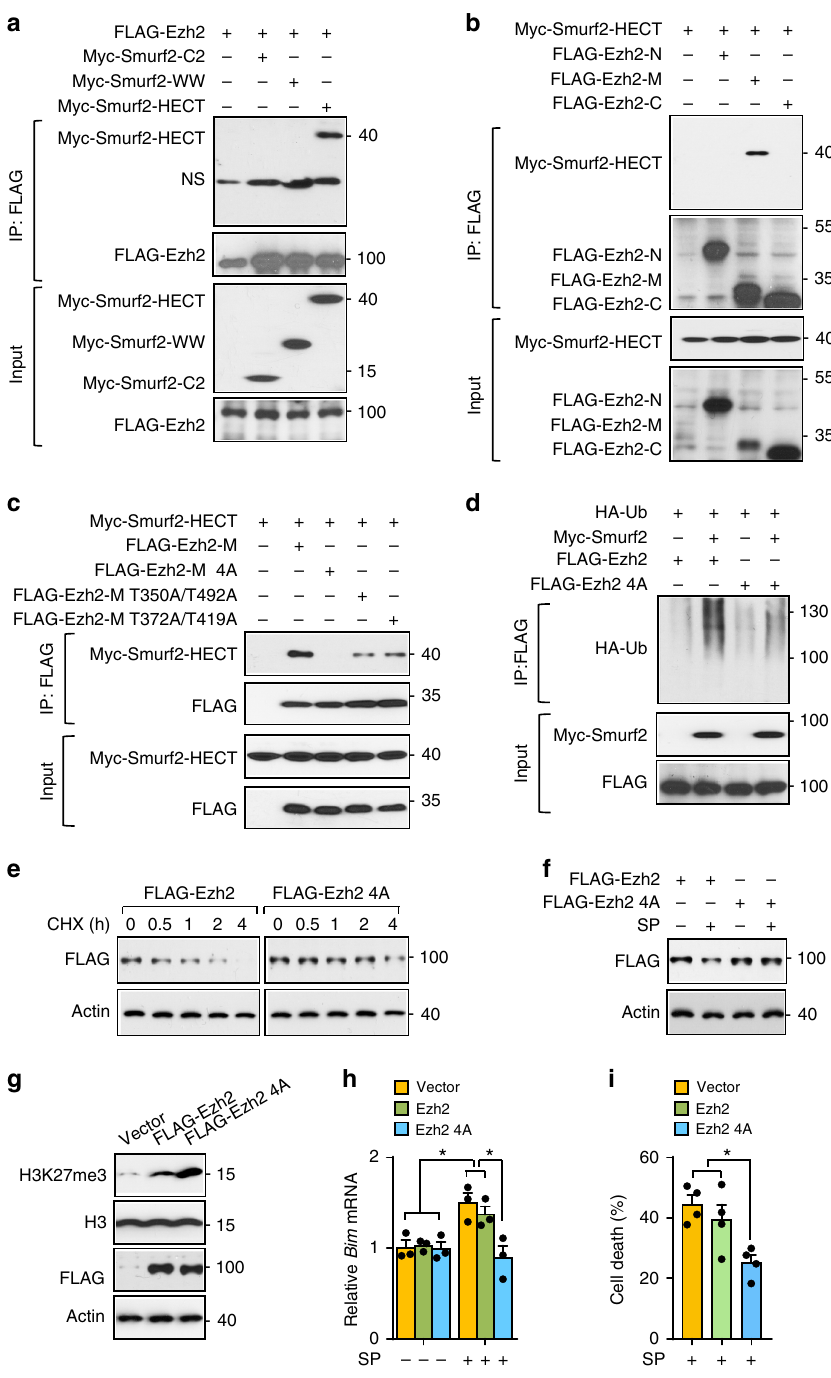
Fig. 6 Multiple cdk1 threonine phosphorylation sites in Ezh2 modulate its full interaction with Smurf2. a HECT domain of Smurf2 interacting with Ezh2 by co-immunoprecipitation. b Binding of middle domain of Ezh2 (Ezh2-M) to Smurf2 by co-immunoprecipitation. c Ezh2-M wild type and mutants were co- transfected with HECT domain of Smurf2 and cell lysates were subjected to co-immunoprecipitation after pre-treatment with MG132 for 6 h. d Ubiquitination of wild-type Ezh2 and Ezh2 4A mutants in cells co-expressing HA-tagged ubiquitin with or without smurf2 in the presence of MG132. e , f Sorted GFP + TF1 cells expressing Flag tagged wild type or 4A mutant Ezh2 were subjected to CHX treatment ( e ) or SP600125 ( f ) and Ezh2 protein abundance was measured by immunoblotting using anti-Flag antibody. g – i In sorted GFP + TF1 cells expressing control or Flag tagged wild type or 4A mutant Ezh2, protein levels of H3K27me3 and total H3 levels measured by immunoblotting ( g ) mRNA expression of Bim by q-PCR ( h ) and cell death by MTT assay ( n = 4) ( i ) after SP600125 treatment. Blots are representative of two independent experiments. Data are shown as mean ± s.e.m. * P < 0.05 (two-tailed unpaired Student ’ s t